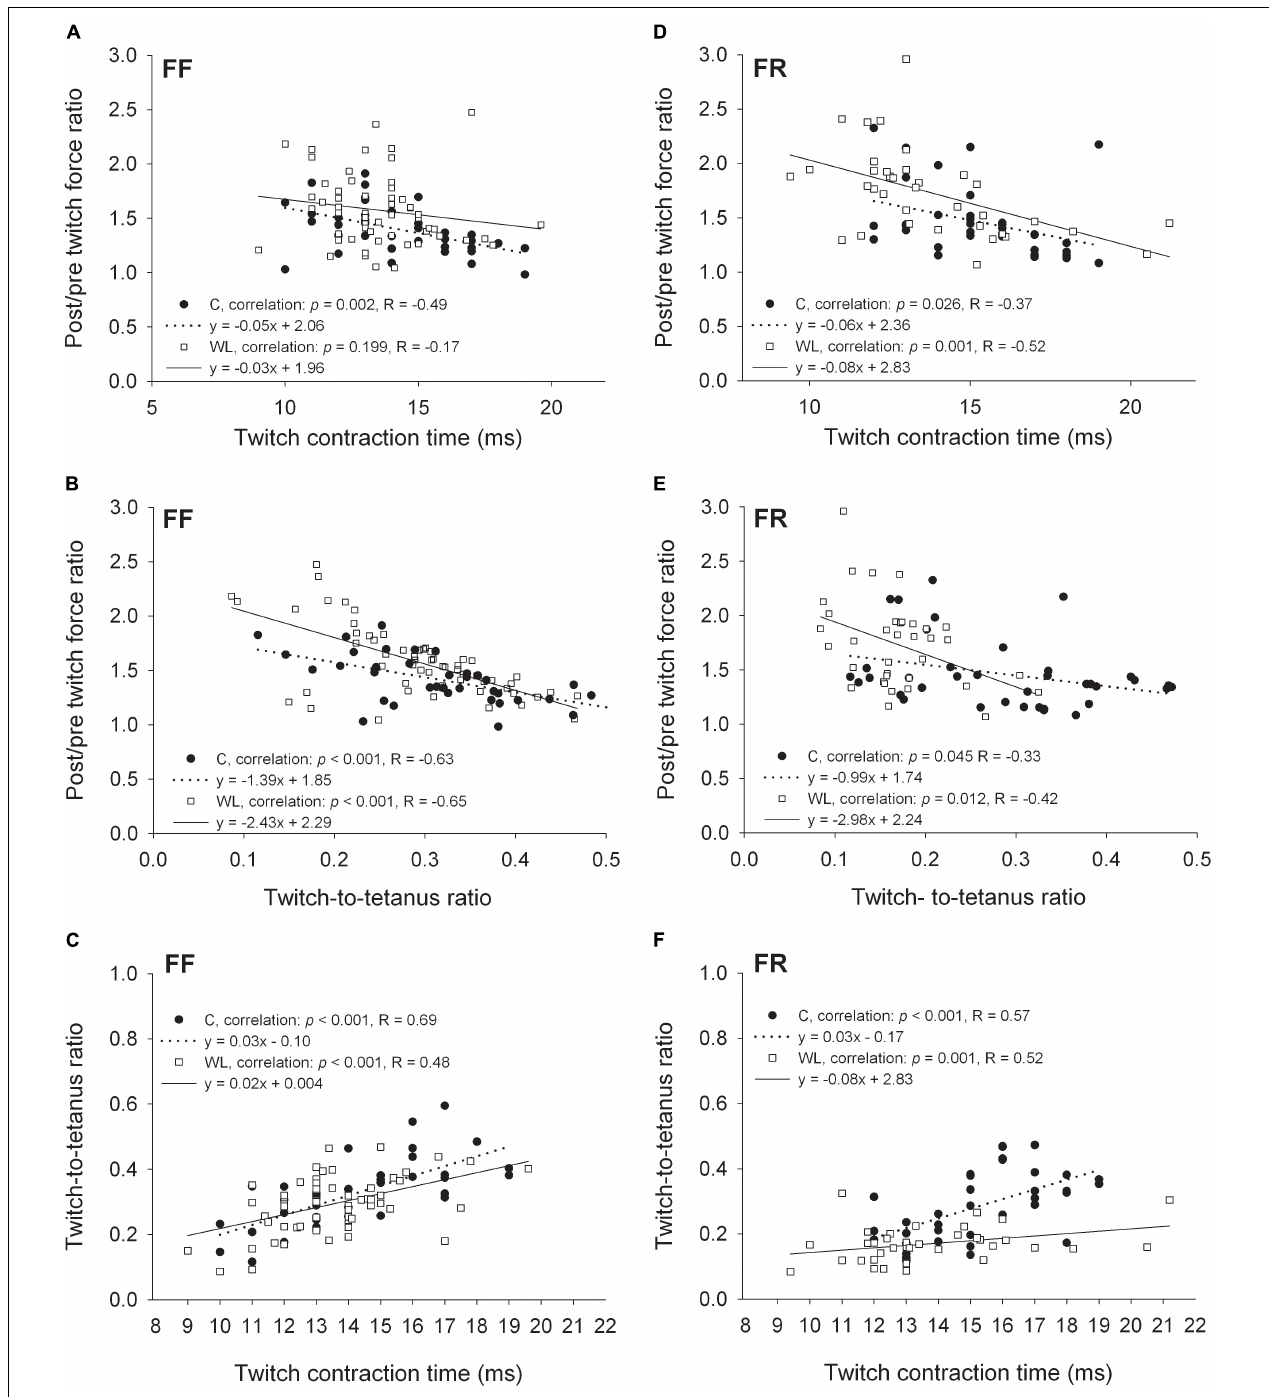
FIGURE 3 | Relationships between the non-potentiated twitch contraction times, twitch:tetanus force ratios, and force ratios of the potentiated to non-potentiated twitches for FF (A–C) and FR (D–F) motor units. C, control group; WL, weight lifting group.